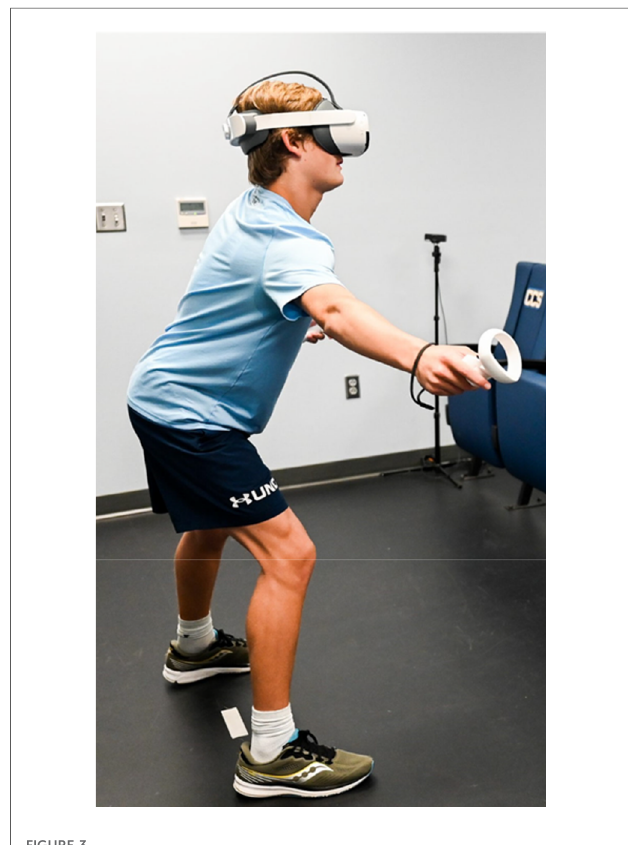
FIGURE 3 Reaching/lunging to contact virtual reality response target with hand